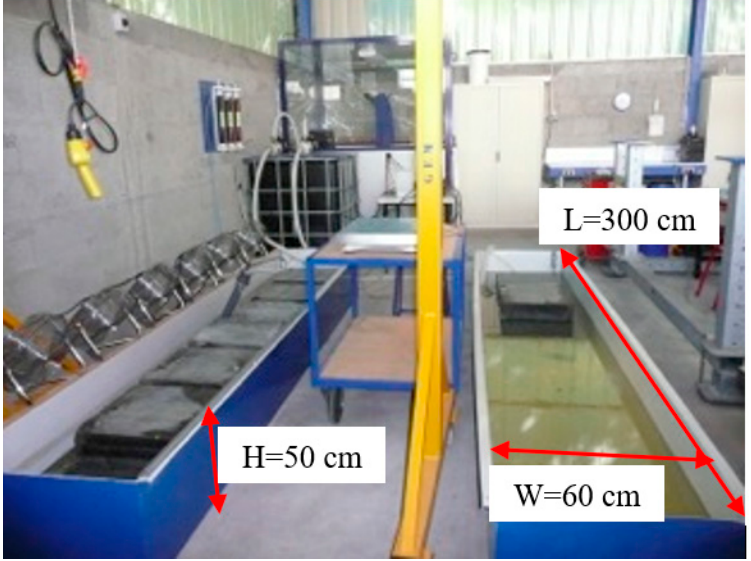
Figure 6. UN-SEA-MDTC, two tanks 300 cm × 60 cm × 50 cm.